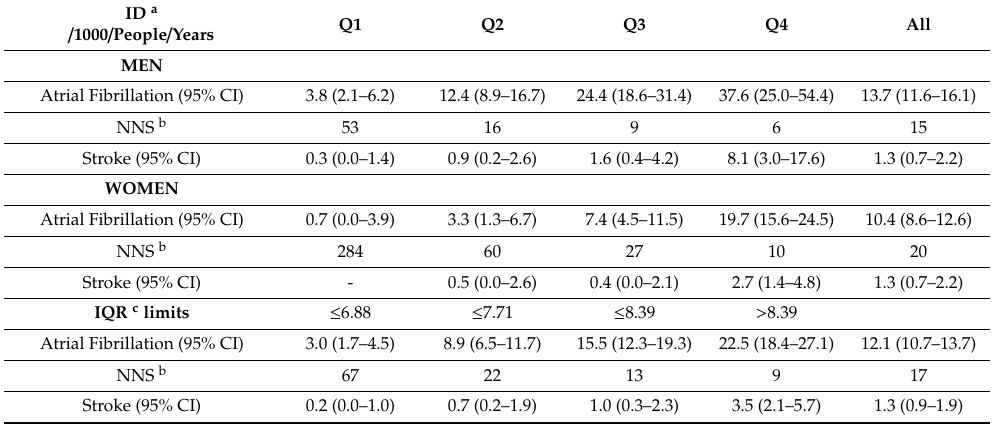
Table 4. Atrial fibrillation and stroke-incidence density according to risk quartile and